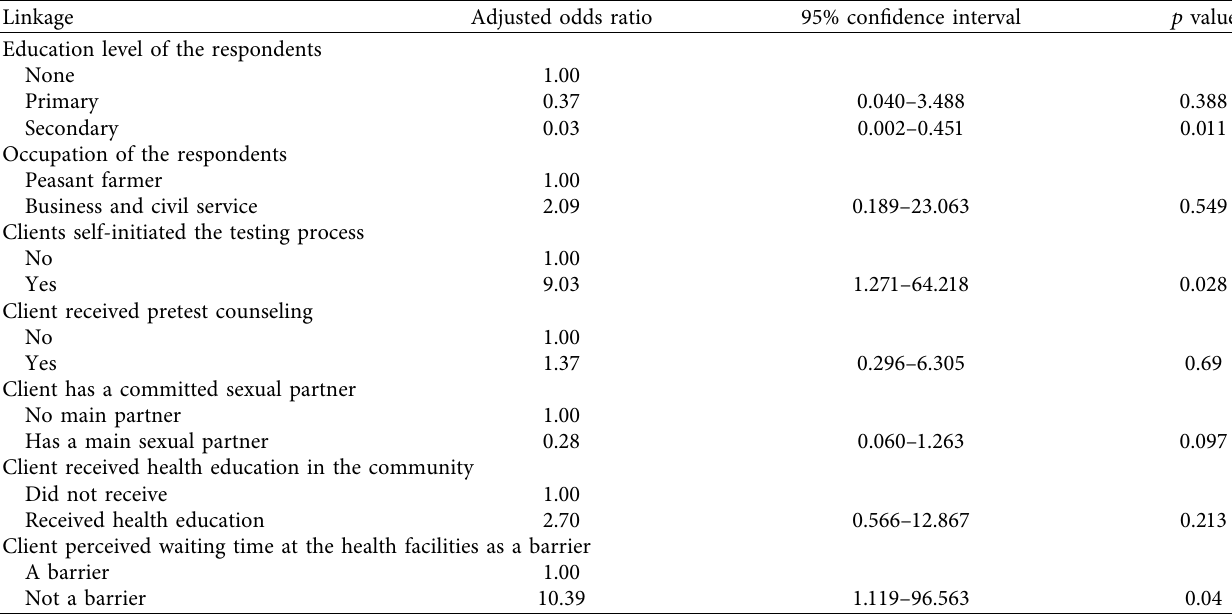
Table 4: Predictors of linkage to HIV following community-level